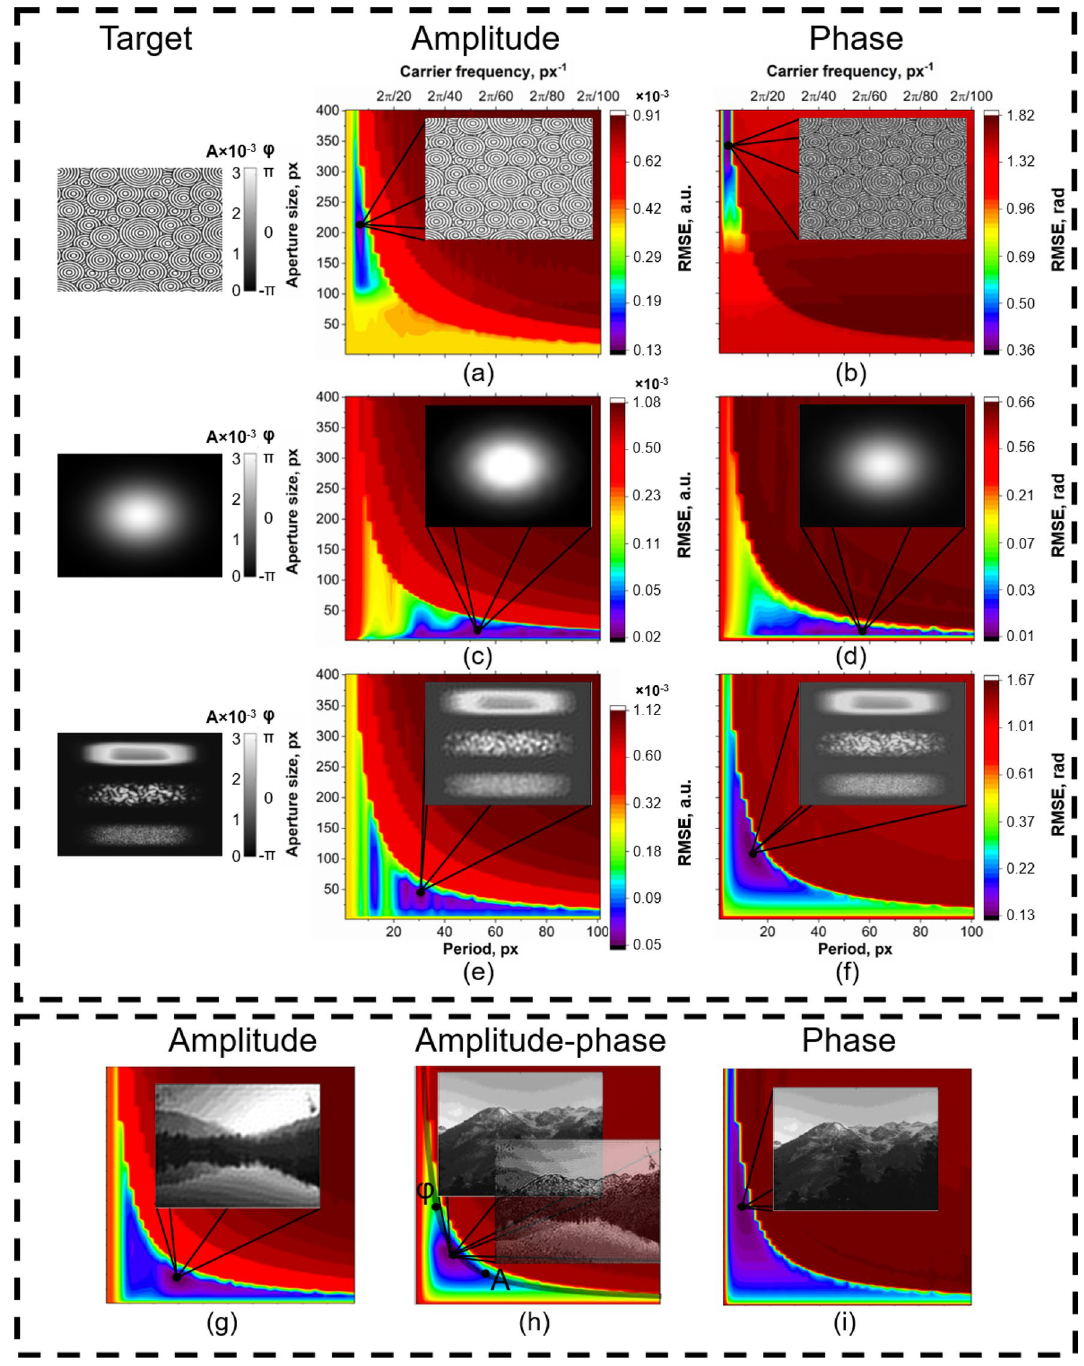
Figure 4. Wavefront modulation error maps for amplitude, phase and amplitude-phase modulation dependent on aperture size and fringe period for different objects. Insets: enlarged fragments, obtained intensity and phase distributions at the minimum RMSE points indicated by the markers. The upper frame shows amplitude ( a , c , e ) and phase ( b , d , f ) modulation error maps for objects “circles”, 2D Gaussian distribution and mixed-frequency phase object. The target distributions are shown on the left. The lower frame shows modulation error maps of amplitude ( g ), phase ( h ), and amplitude-phase ( i ). The minimal RMSE for amplitude-phase modulation lies approximately in the medium of amplitude and phase optimal